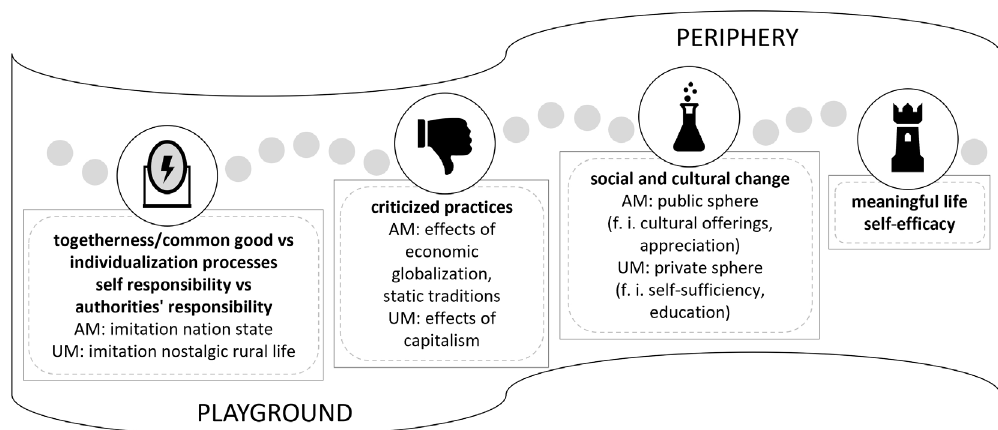
Fig. 3 Aigues-Mortes and Uckermark as